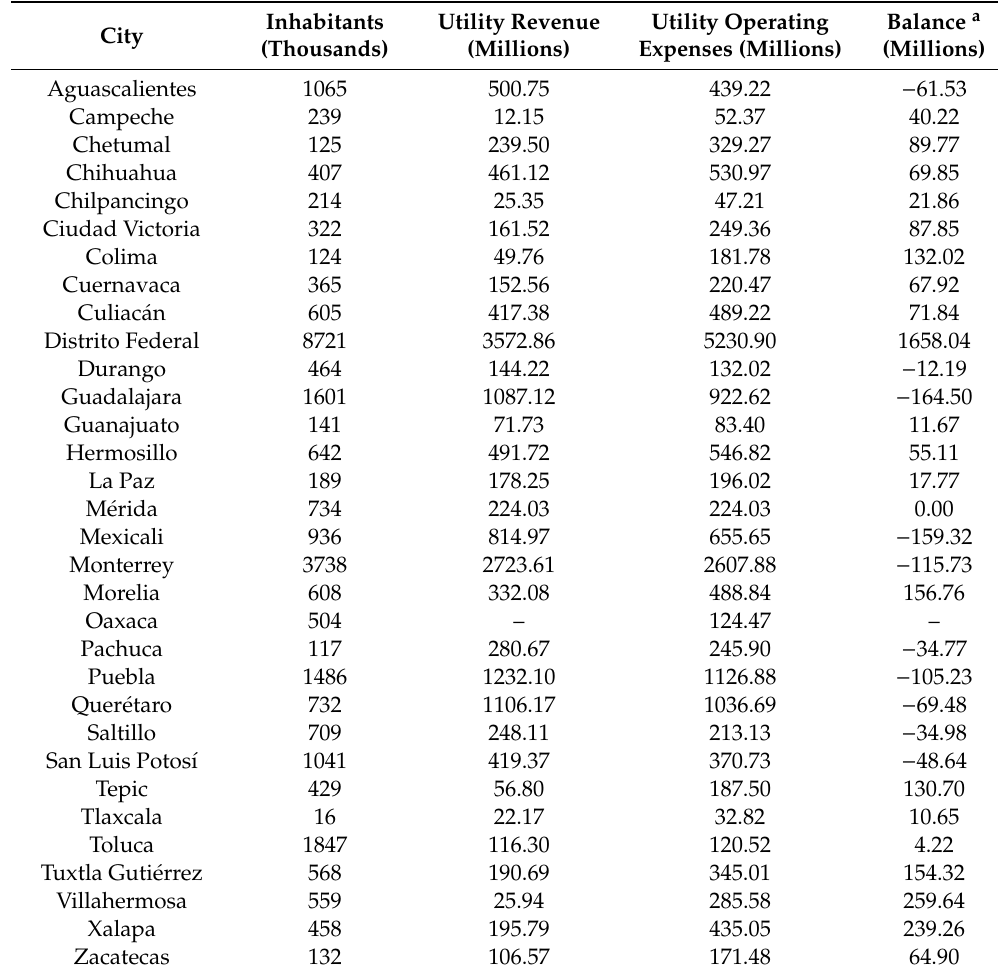
Table 2. Water management in capital cities of Mexican